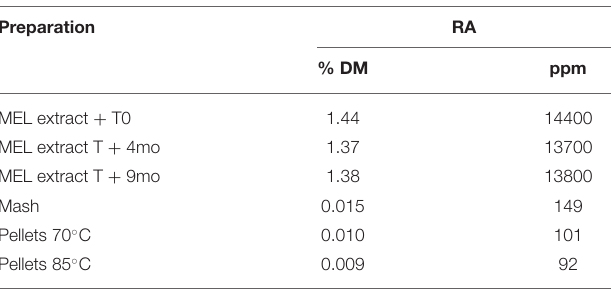
TABLE 4 | Proportion of RA in MEL extract and during the process of supplemented feed production. Preparation